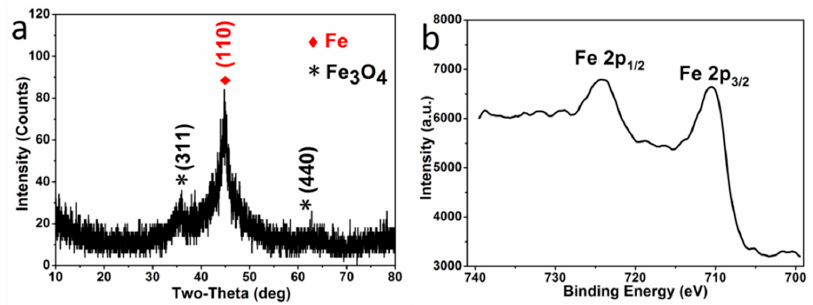
Figure 1. XRD pattern ( a ) and Fe 2p XPS high resolution spectroscopy ( b ) of Fe 0 /Fe 3 O 4 microparticles P 0.0525 .